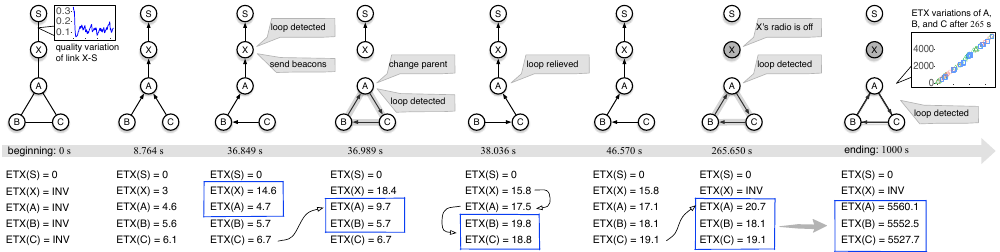
Figure 3. Snapshots of the CTP in experiment T-I, during which node X is shut down at the 260th second. The time point below each topology timestamps the current experiment snapshot. The ETX values listed are the route ETX (routing gradient) instead of the link